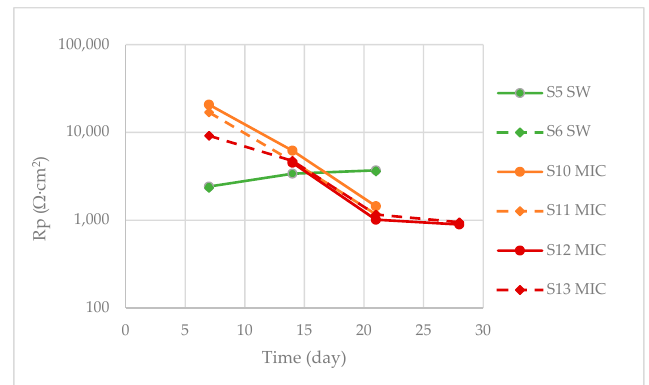
Figure 6. Polarization resistance measured by LPR as a function of time measured for R4 steel samples in seawater with and without bacteria. S5 and S6 in SW showed the same LPR values.